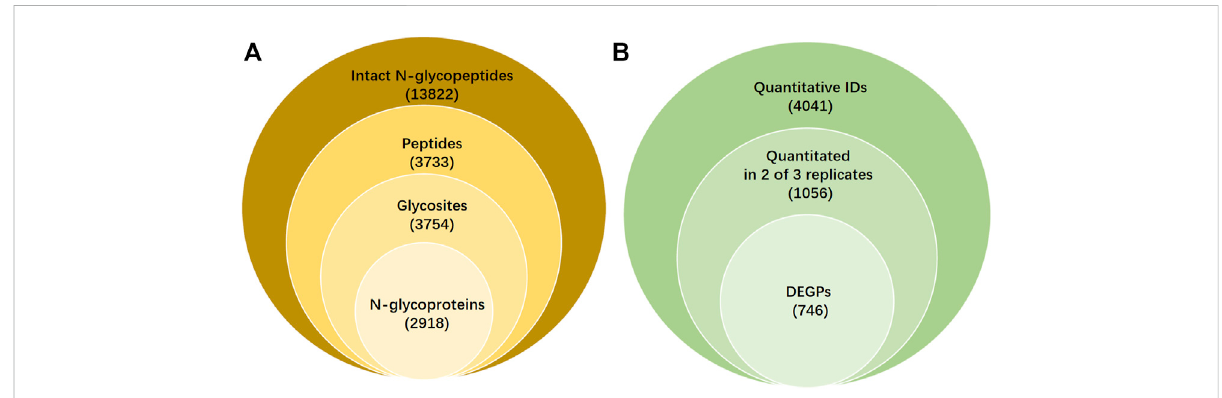
FIGURE 1 Qualitative and quantitative results and differentially expressed intact N-glycopeptides (DEPGs) in SKOV3 and IOSE80 cells. (A) Qualitative informationonintactN-glycopeptides IDsincludingglycosites,peptides,andN-glycoproteinidenti fi edbyGPSeekerwithFDR ≤ 1%fromC18-RPLC- MS/MS (HCD) analysis in 1:1 mixed SKOV3 and IOSE80 cells. (B) Quantitative results of differentially expressed N-glycopeptides searched by GPSeekerQuan.